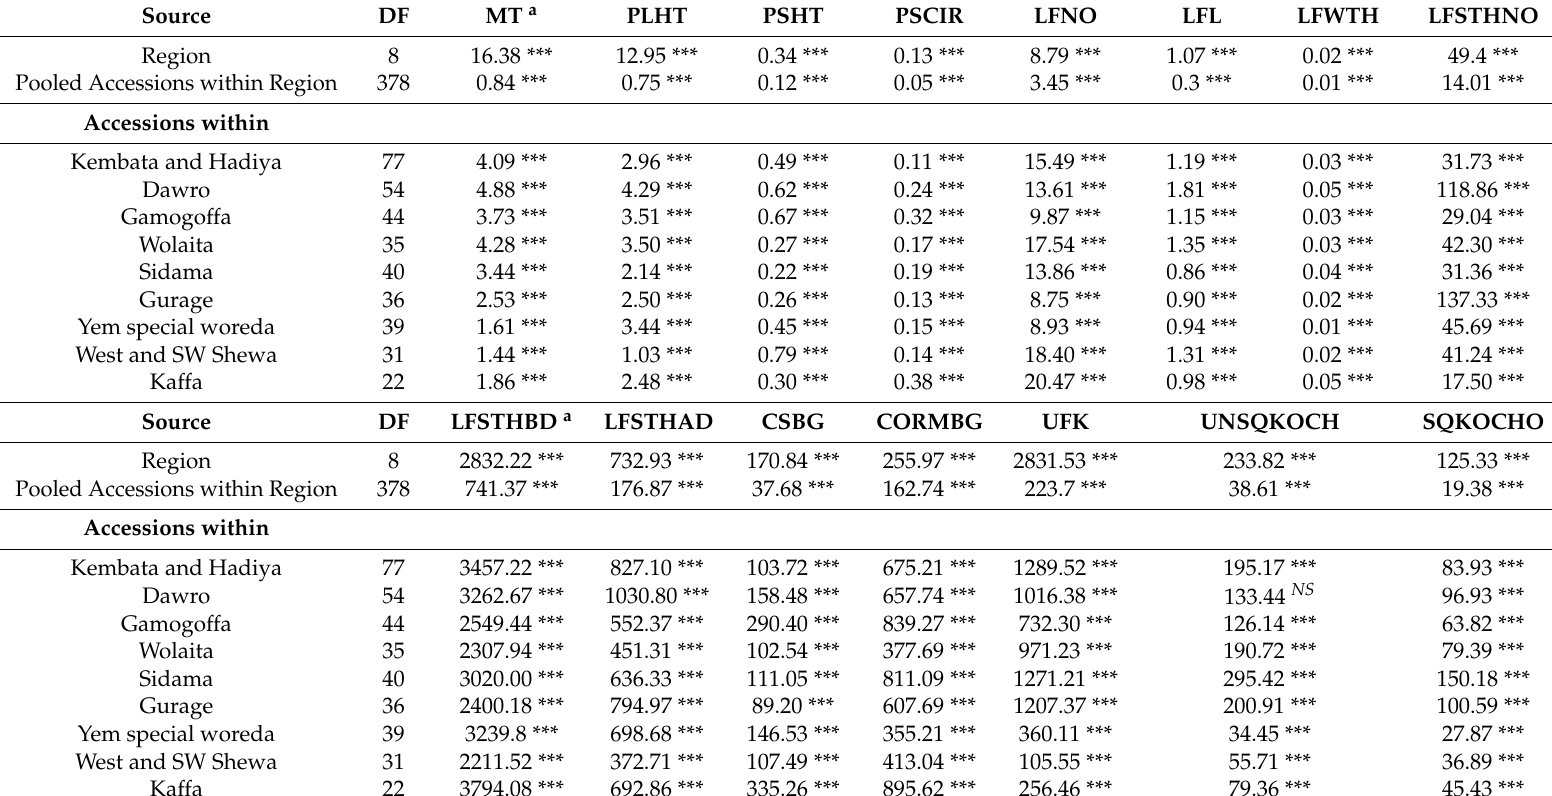
Table 2. Analysis of variance for 9 regions based on 15 quantitative characteristics in enset